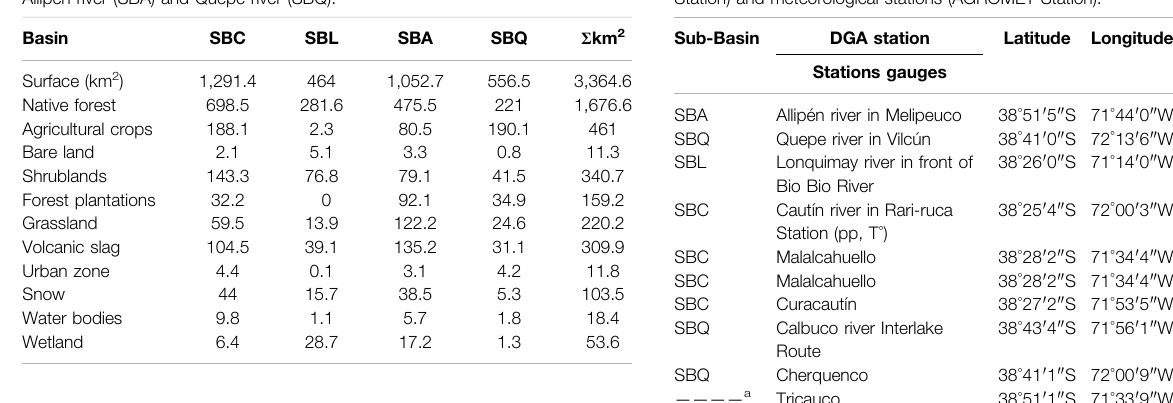
TABLE 2 | Meteorological Stations and Stream fl ow gauging stations (DGA Station) and meteorological stations (AGROMET